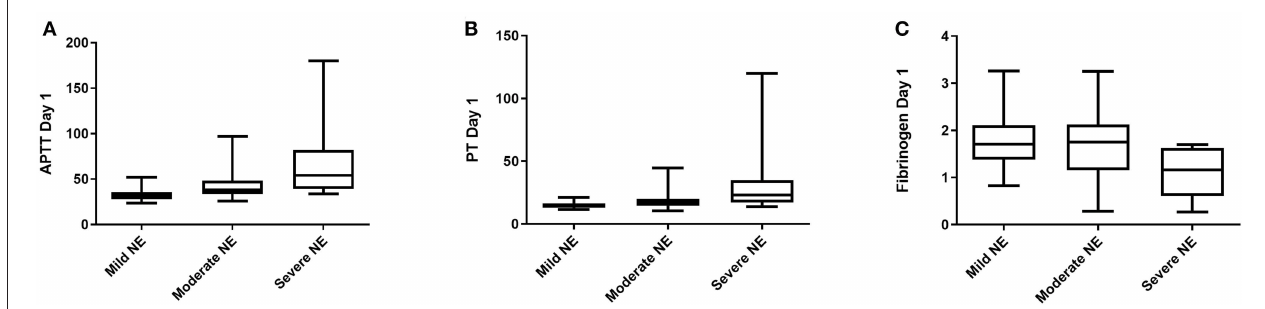
FIGURE 2 | Coagulation screens and correlation with clincial outcomes. (A) APTT, Activated Partial Thromboplastin Time (s); (B) PT, Prothrombin Time (s); (C) Fib, Fibrinogen (g/L). Grade I NE, Mild; Grade II NE, Moderate; Grade III NE,